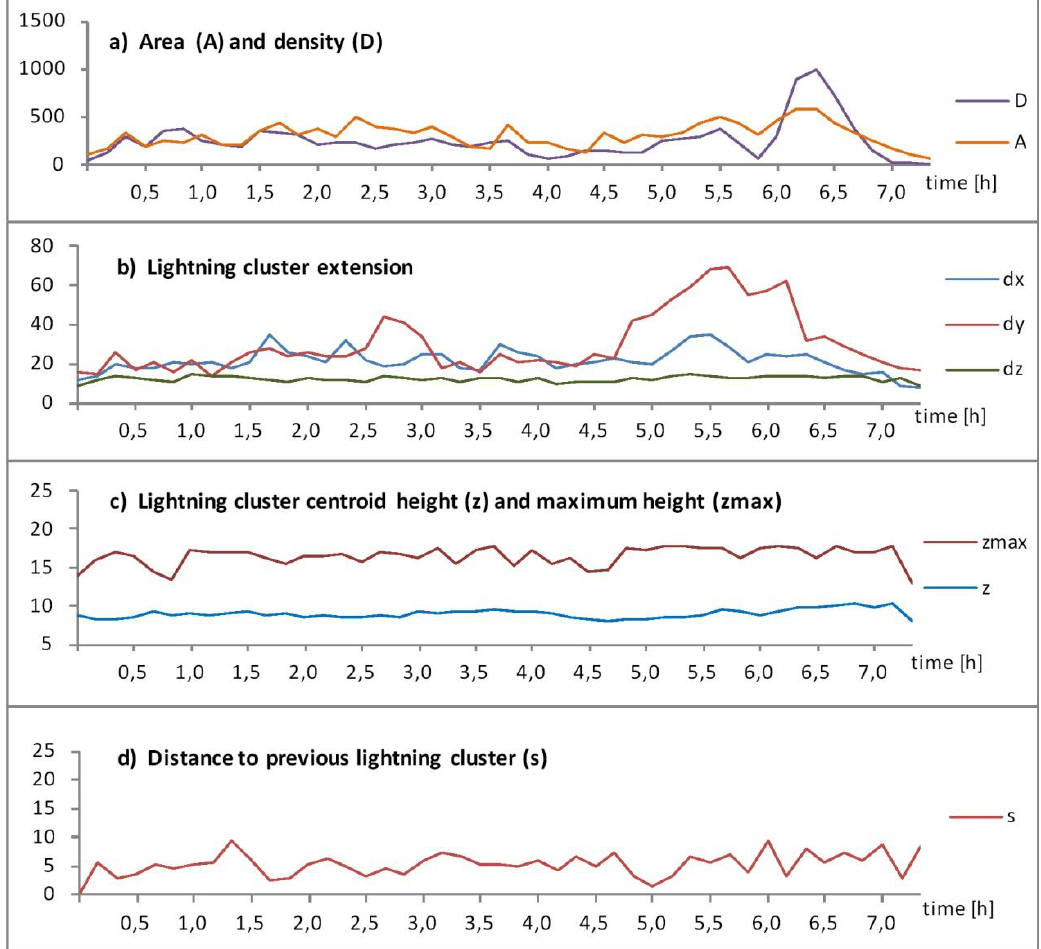
Figure 9. Estimated lightning cluster features of an exemplary track during its entire lifetime: ( a ) cluster area A in (km 2 ) and density D ; ( b ) cluster 3D spatial extension dx , dy , dz in (km); ( c ) cluster centroid height z and maximum height zmax in (km); ( d ) cluster distance to previous cluster s in